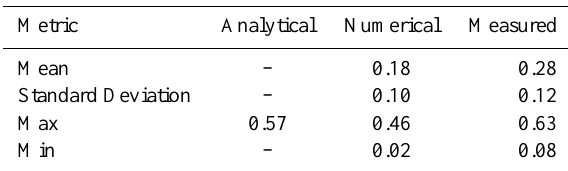
Table 7. Center shift data for analytical model, numerical model, and measured behavior. Analytical maximum center shift is a root sum squared total for a single hinge. Numerical and measured data were collected from 45 distinct sets of applied torques. All data are in